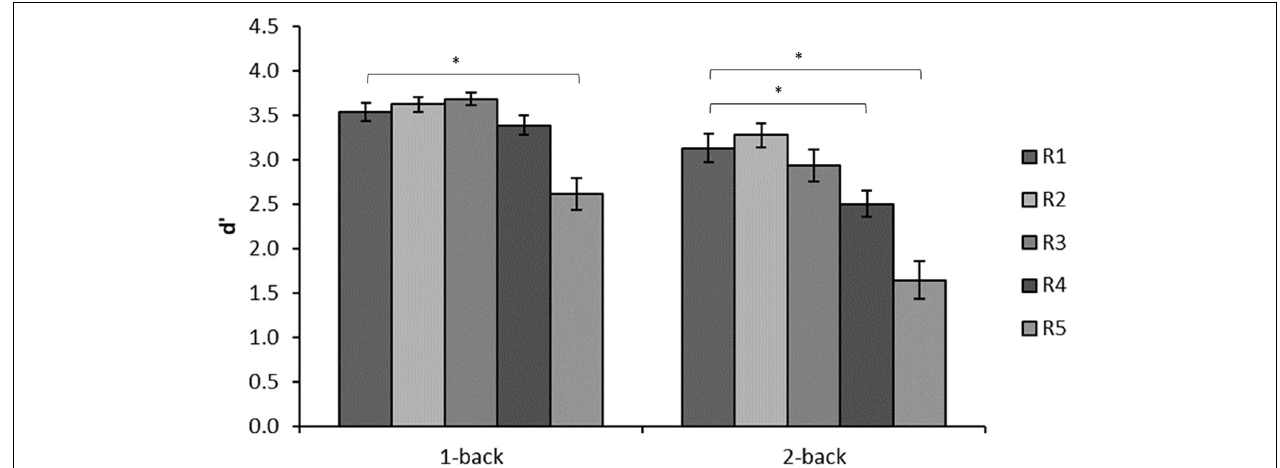
FIGURE 3 | Mean d (cid:48) in each of the conditions of the n-back experiment. D (cid:48) is based on hits adjusted for false alarms in accordance with signal detection theory. Resolution decreases with increasing R. Reprinted from Rudner et al.